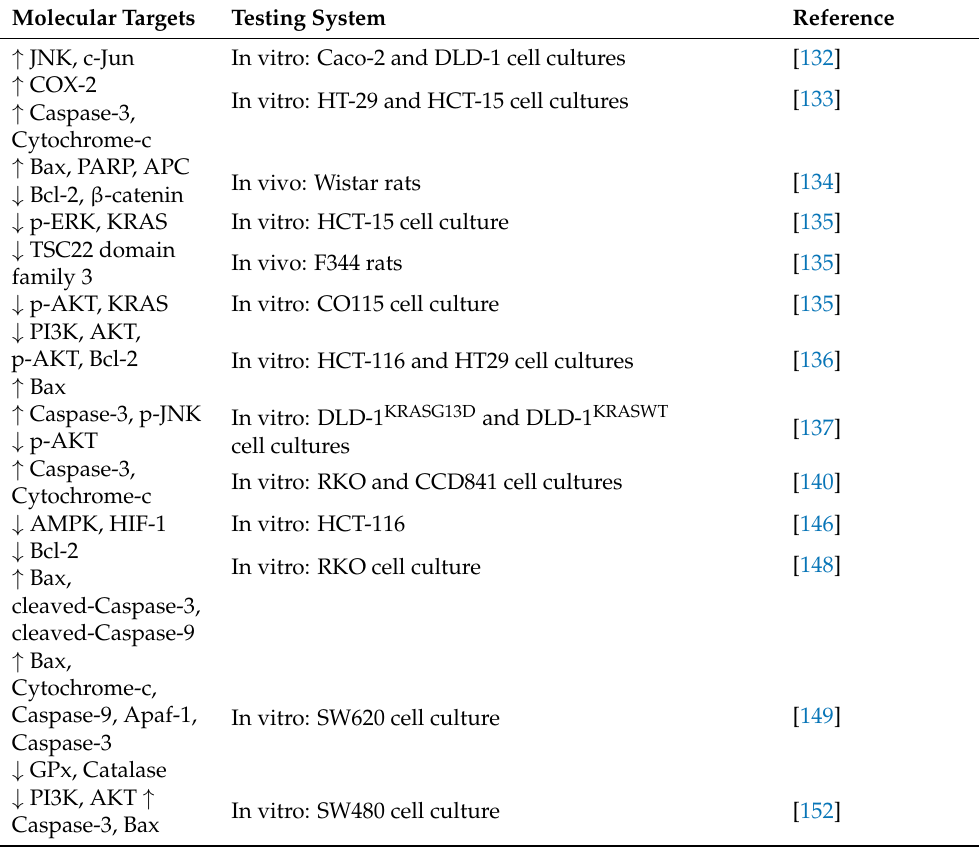
Table 5. Reported targets of quercetin active in induction of apoptosis of CRC models alongside their in vivo/in vitro testing system. “ ↑ ” and “ ↓ ” arrows are indicating the up- and down-regulation, respectively, while “?” denotes the lack of specific targets in the respective